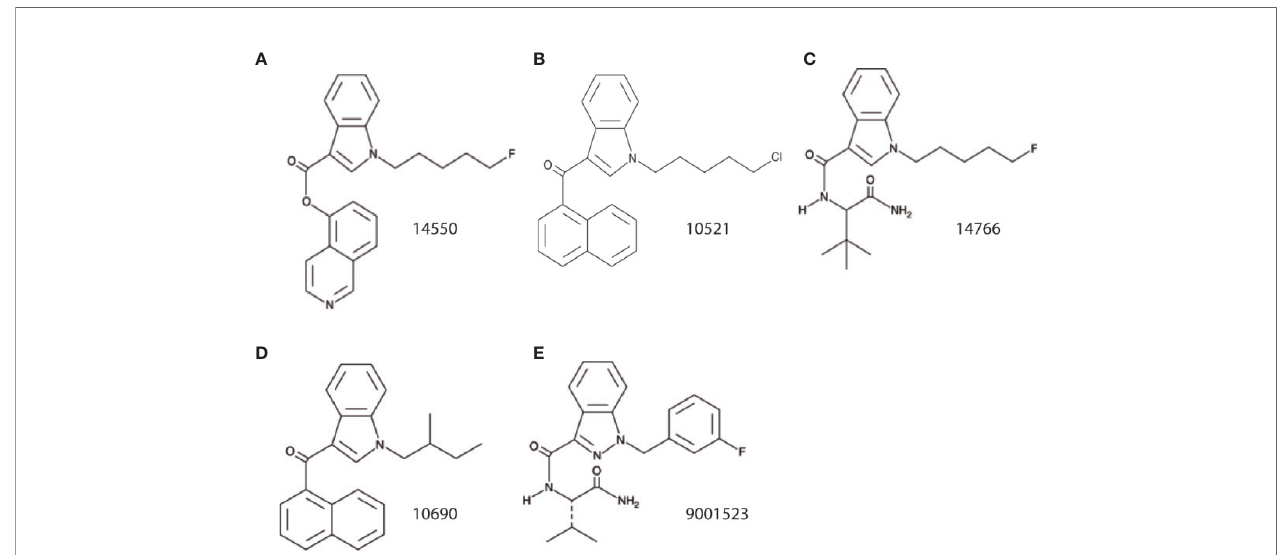
FIGURE 4 | Structural comparison of SC identi fi ed to reduce spontaneous seizures in the scn1lab Dravet syndrome zebra fi sh mutant. (A) 14550; 5- fl uoro PB-22 5- hydroxyisoquinoline isomer, (B) 10521; JWH 018 N-(5-chloropentyl) analog, (C) 14766; 5- fl uoro ADBICA, (D) 10690; JWH 018 N-(2-methylbutyl) isomer, and (E) 9001523; AB-FUBINACA 3- fl uorobenzyl